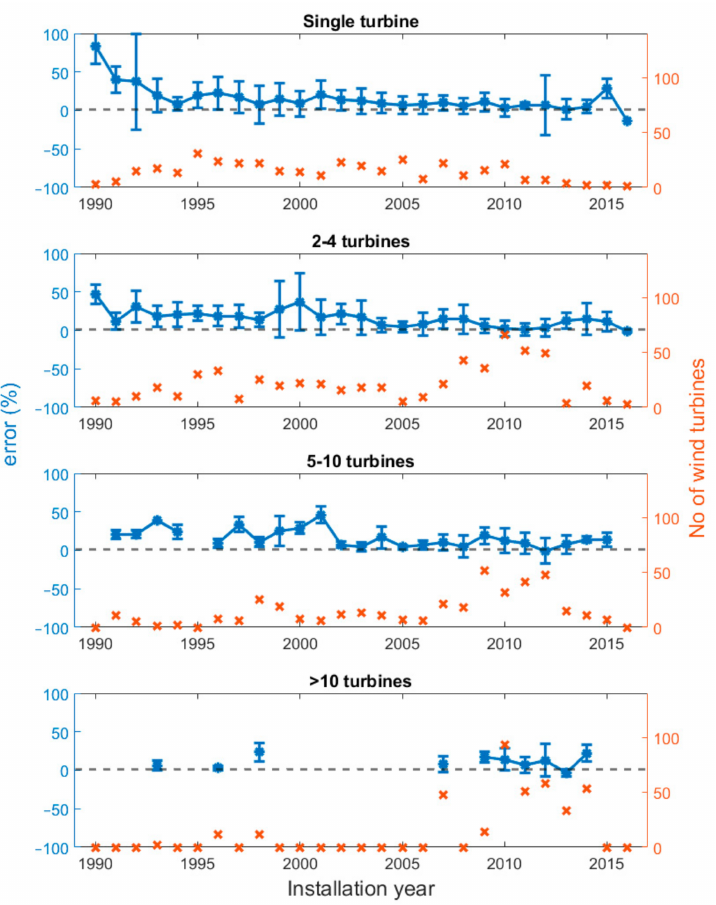
Figure 8. The time development of the AEP prediction accuracy divided on wind farm size with number of wind turbines for each